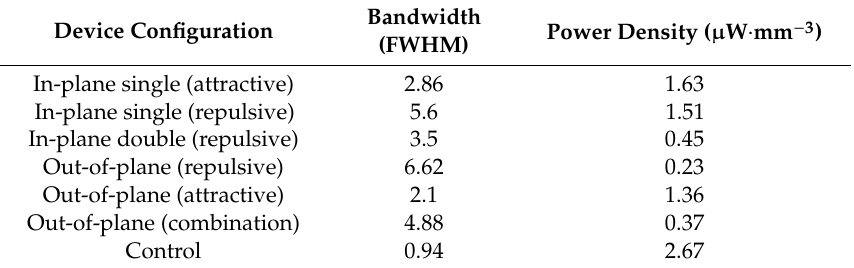
Table 1. Comparison of di ff erent configurations as demonstrated for 0.1 g. FWHM, full-width,